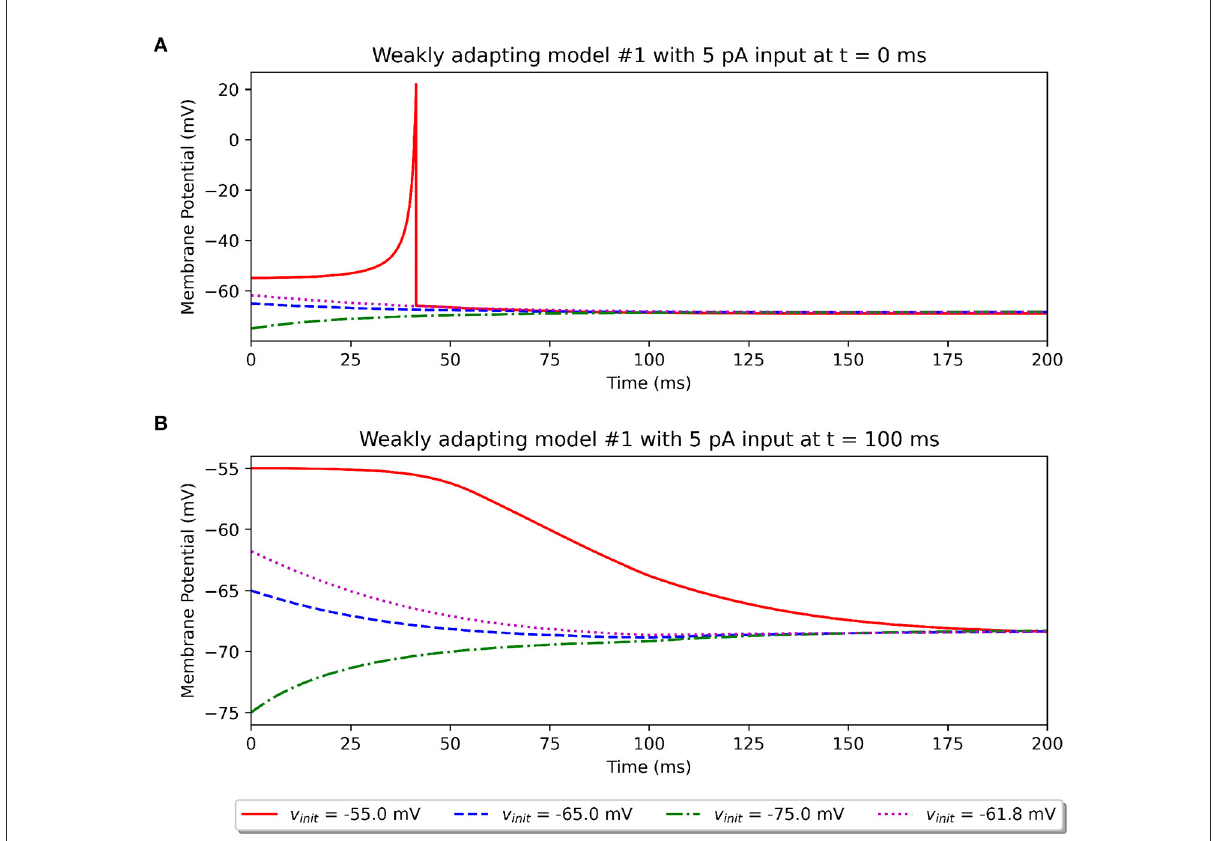
FIGURE7 Simulations illustrating the effect of varying values for the initial resting potential using the Original model. (A) Shows the response to a 5 pA stimulus applied at t = 0 ms, and (B) shows the same stimulus applied at t = 100